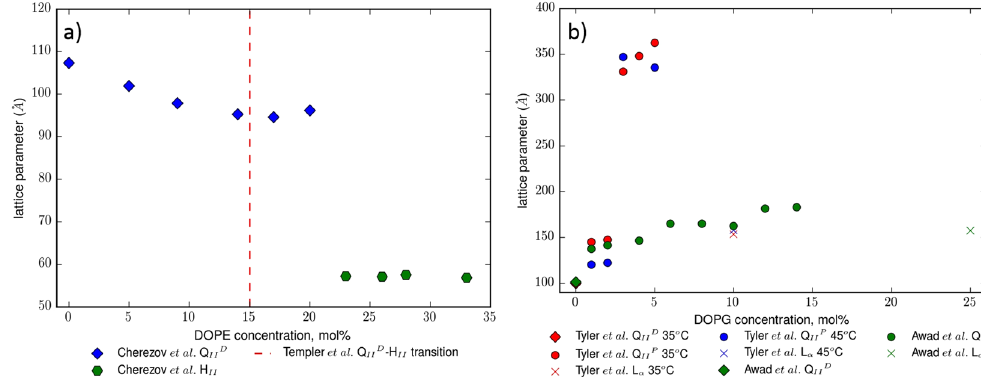
Figure 1. An overview of the present literature understanding of the phase behaviour of Monoolein when doped with increasing molar proportions of ( a ) DOPE and ( b ) DOPG. ( a ) demonstrates that upon addition of zwitterionic DOPE, Cherezov et al . 19 found a slight decrease in the Q IID phase lattice parameter, before the system took on the inverse hexagonal phase at above 20 mol%, a similar finding to phase work (with no lattice parameter information) done by Templer et al . 20 . ( b ) Shows that the work of Tyler et al . 21 and Awad et al . 25 finds an initial phase change from Q IID to Q IIP upon addition of the anionic lipid DOPG, a subsequent swelling of the Q IIP phase, before a further phase change to the L α . We note, however, that Tyler et al . undertook their experiments at temperatures too high for practical application purposes, and that Awad et al . undertook their measurements in a 10 mM PIPES